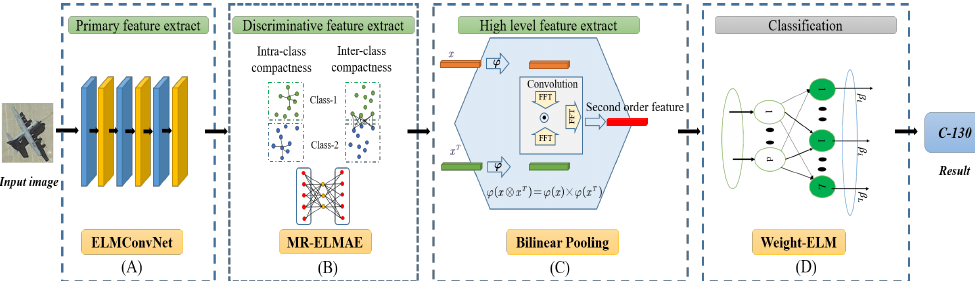
Figure 2. Pipeline of the BD-ELMNet method. ( A ) ELMConvNet structure. ( B ) Use of the MRELM-AE to extract mid-level robust discriminative features. ( C ) Enhancement of the feature expression ability of the ELM-LRF by extracting high-level features through bilinear pooling. ( D ) Use of the weighted ELM as a supervised classifier to solve the problem of unbalanced training